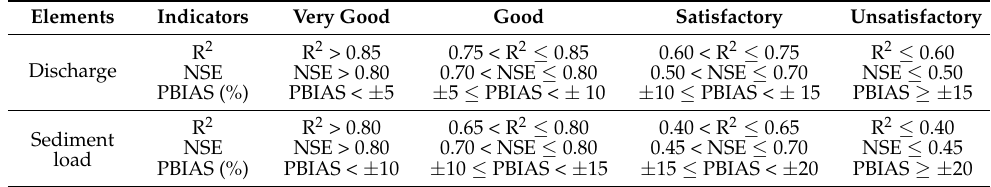
Table 1. Model performance for discharge and sediment load simulation at the monthly scale [36].